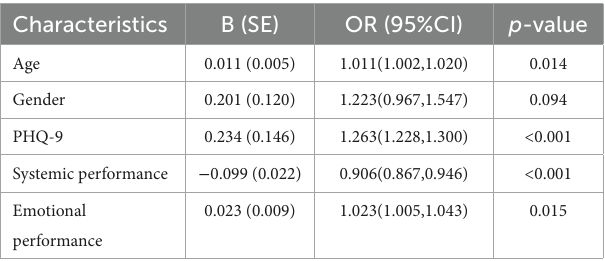
TABLE 5 Risk factors of the presence of poor sleep quality derived from backward stepwise logistic regression analysis. Characteristics